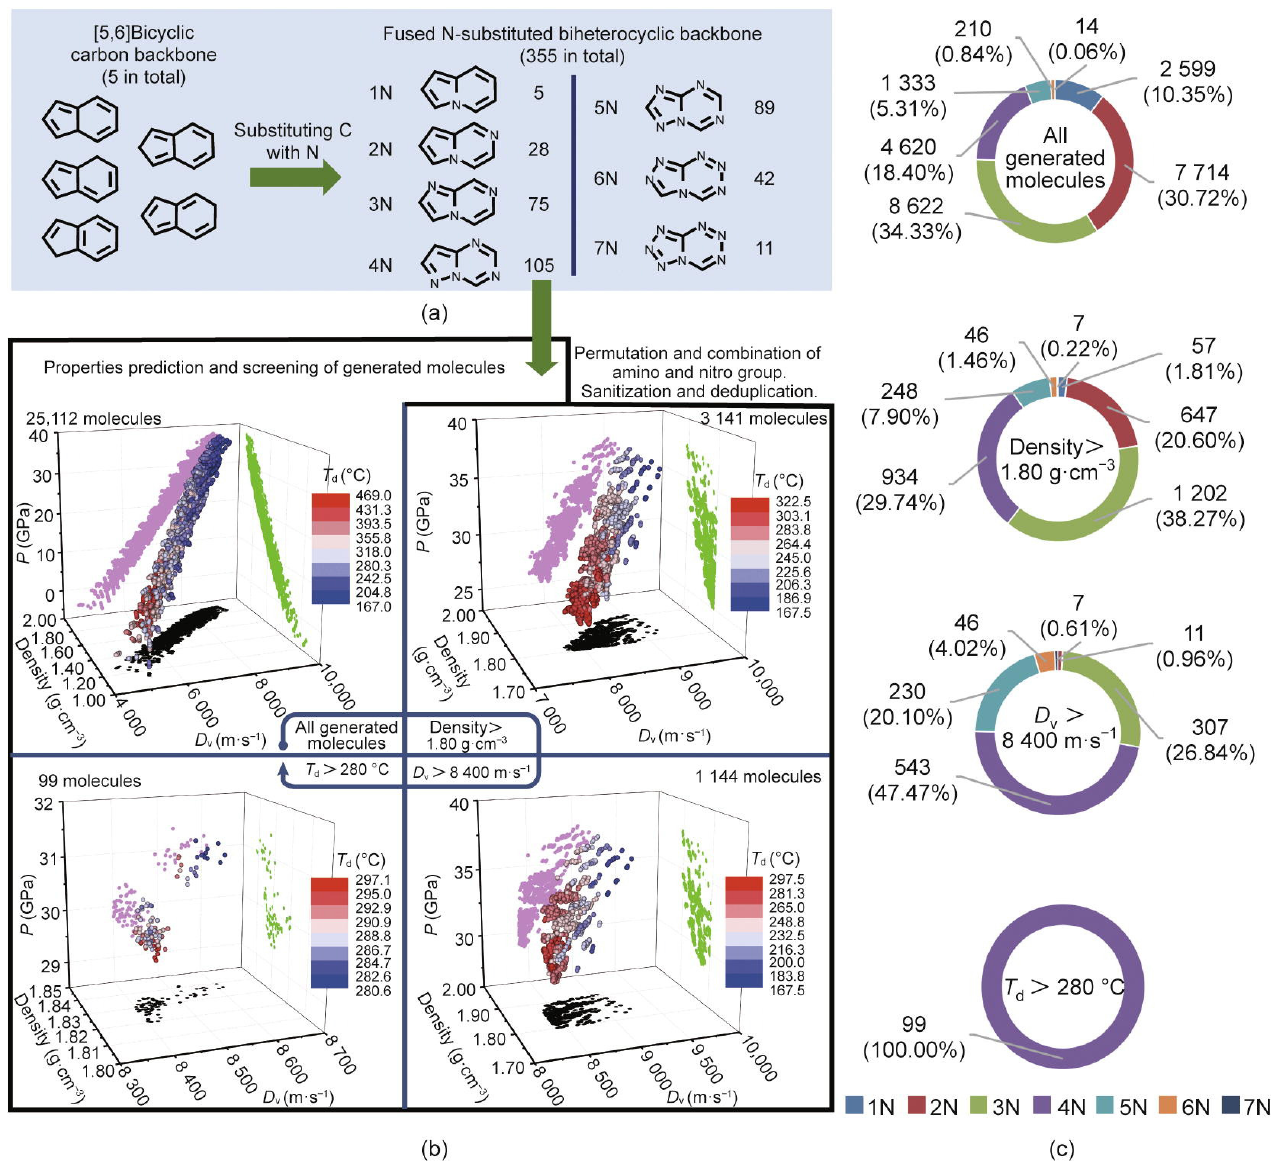
Figure 10. Process of generating and screening the molecules. ( a ) Illustration of the generation process. ( b ) Color-mapped 3D scatter plots of the molecules in original and different screening steps. ( c ) Proportions of other nitro-atom-substituted fused [5,6] biheterocyclic molecules in original and different screening steps [1]. Copyright 2022 Elsevier.